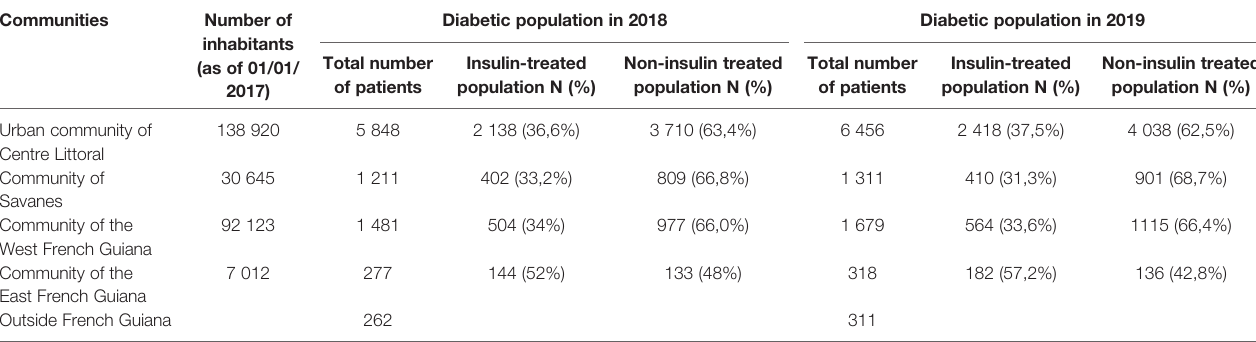
TABLE 1 | Distribution of patients with diabetes by region in 2018 and 2019.